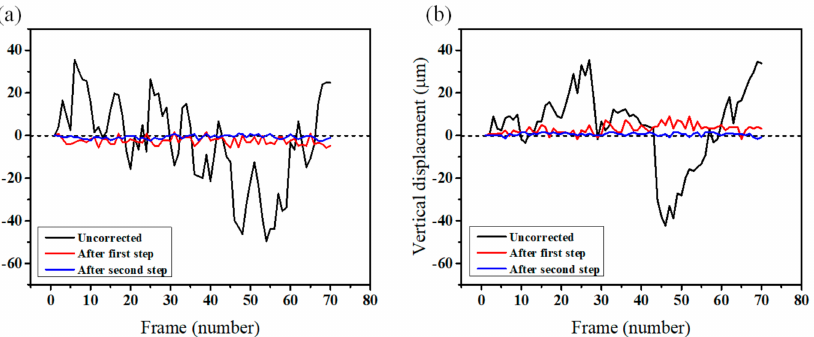
Figure 7. Comparison of the displacement values between uncorrected (black line) and motion- corrected (red and blue lines) image sequence. Red line indicates the displacement values after the first registration step, and the blue line represents after the second motion correction step. ( a ) Horizontal displacement values. ( b ) Vertical displacement